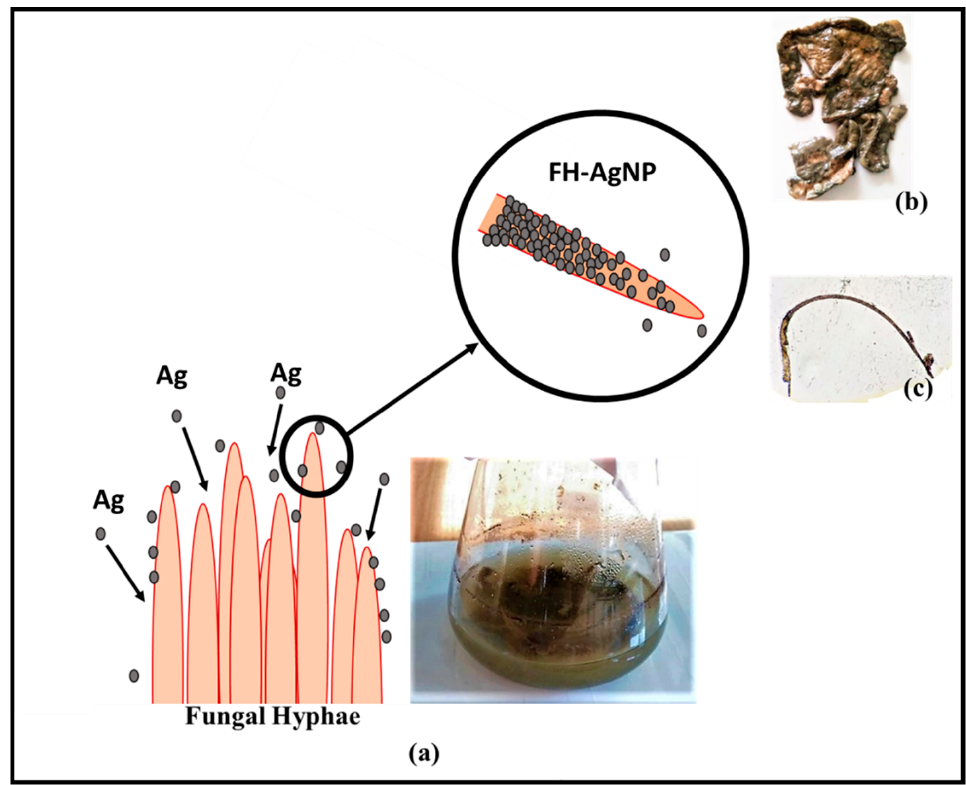
Figure 1. Schematic representation of the synthesis of FH-AgNPs. ( a ) Fungal biomass incubated with AgNPs. ( b ) Fungi-templated AgNPs. ( c ) Optical microscopic image of fungi filament templated with